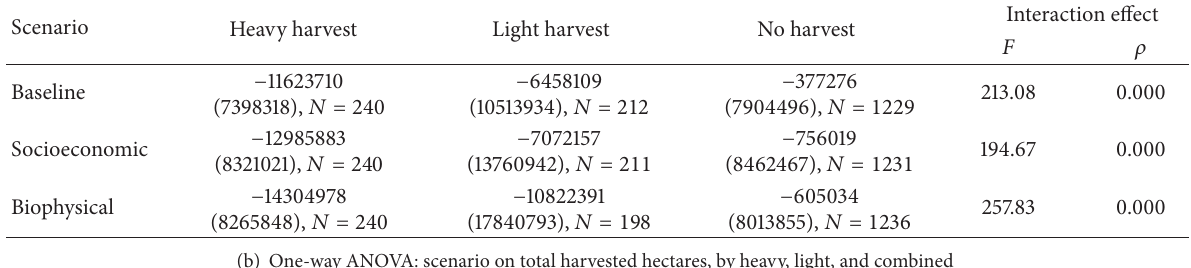
Table 4: Harvesting and goal score ANOVA output. Mean standard deviations (between brackets), sample size and interactions of goal score changes, and hectares harvested by scenario and action. Significant differences in means are